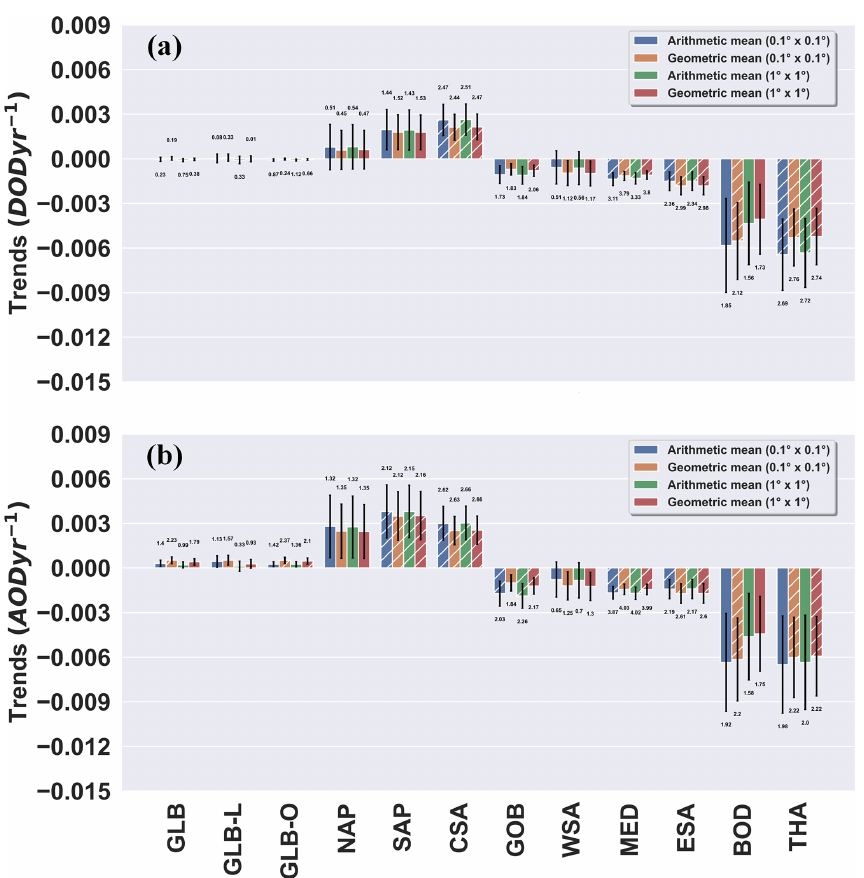
Figure 8. Bar plots indicating the (a) DOD and (b) AOD regional temporal trends. The hatched bars represent regions with significant trends ( | ω/σ ω | > 2 . 0). The error bars denote the uncertainty of the trends based on Eq.(3) (Sect.